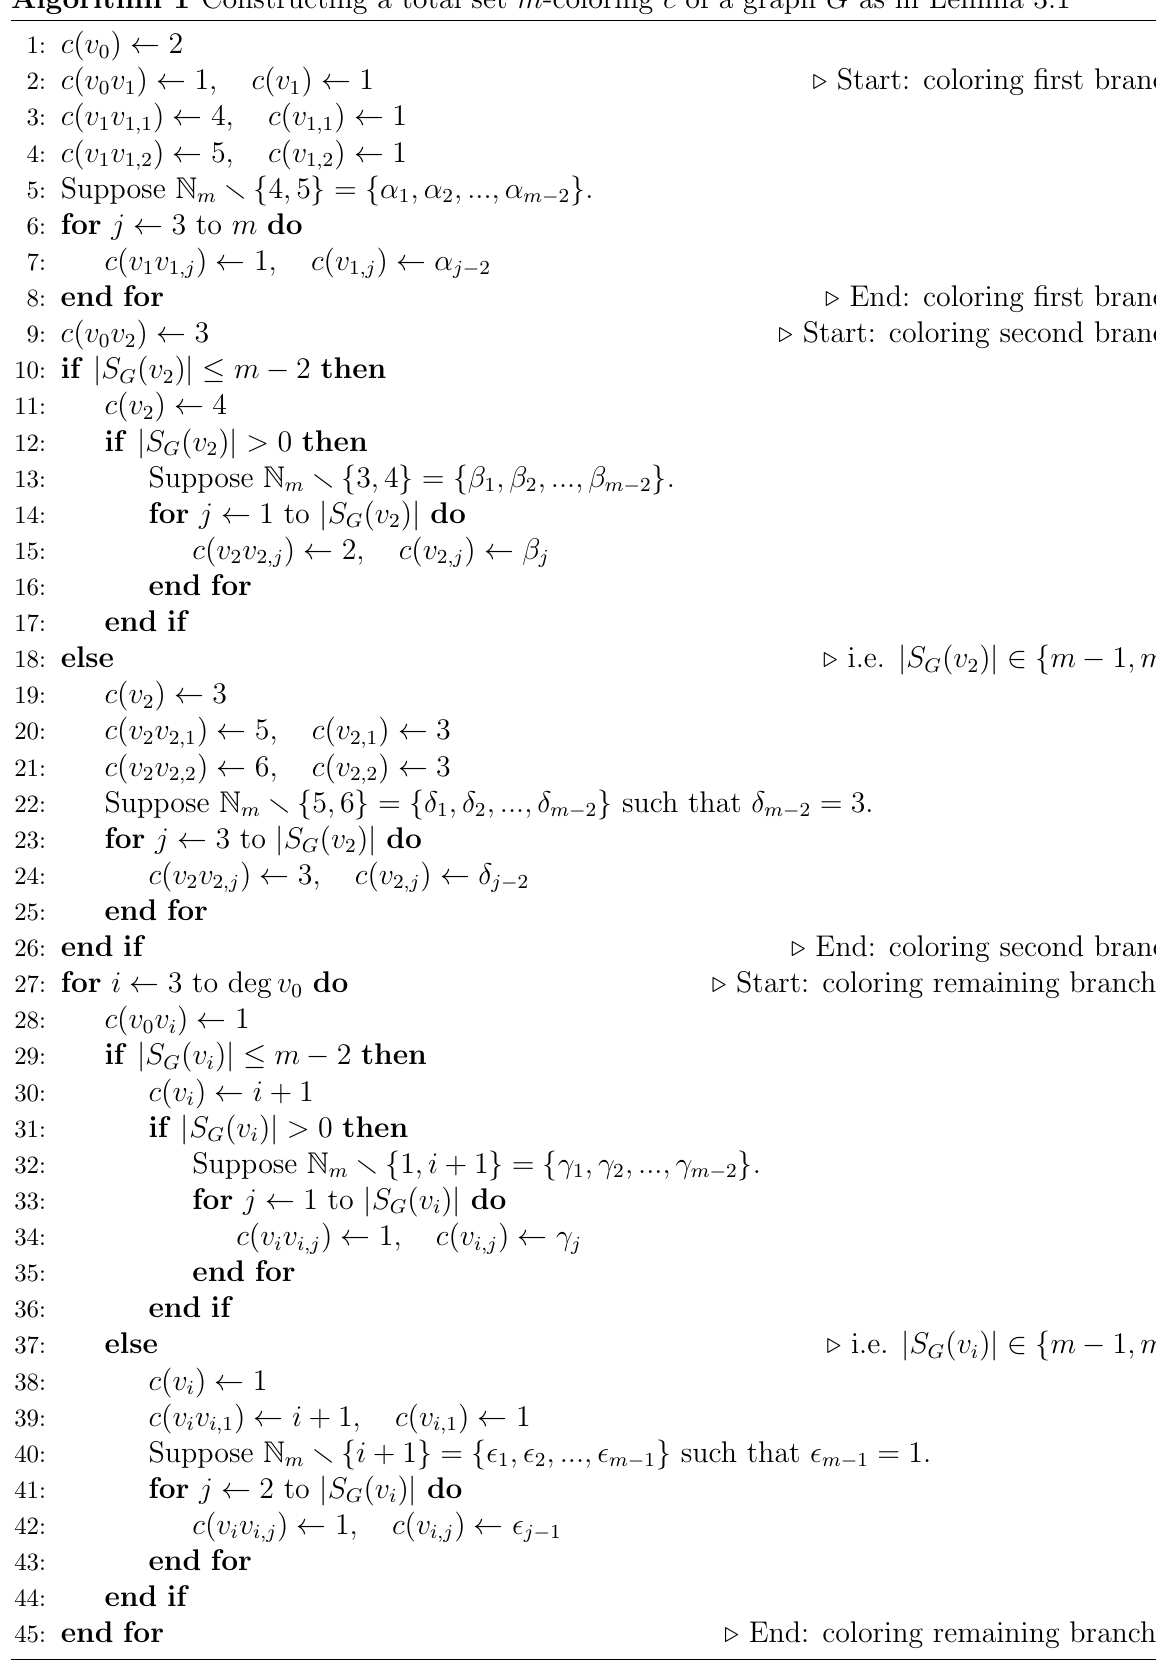
Algorithm 1 Constructing a total set m -coloring c of a graph G as in Lemma